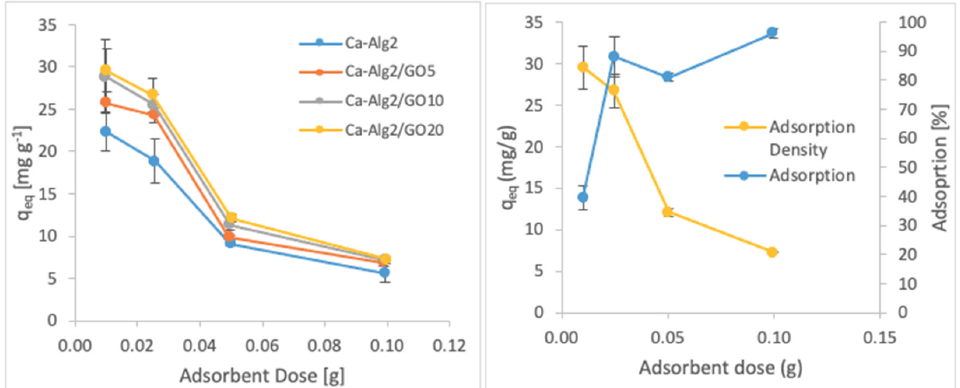
Figure 8. Effect of the adsorbent dose on qeq FMTD.